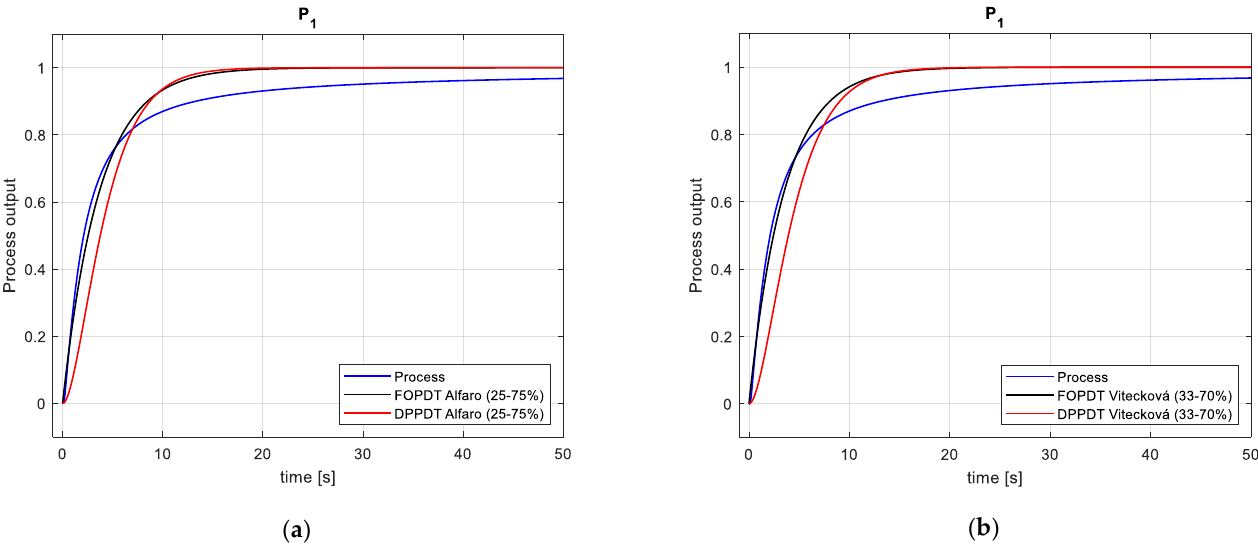
Figure 11. FOPDT and DPPDT model step responses using integer-order model identification methods for process P 1 and process reaction curve: ( a ) Alfaro [11] (25 – 75%); ( b ) Vitecková et al. [14] (33 – 70%).